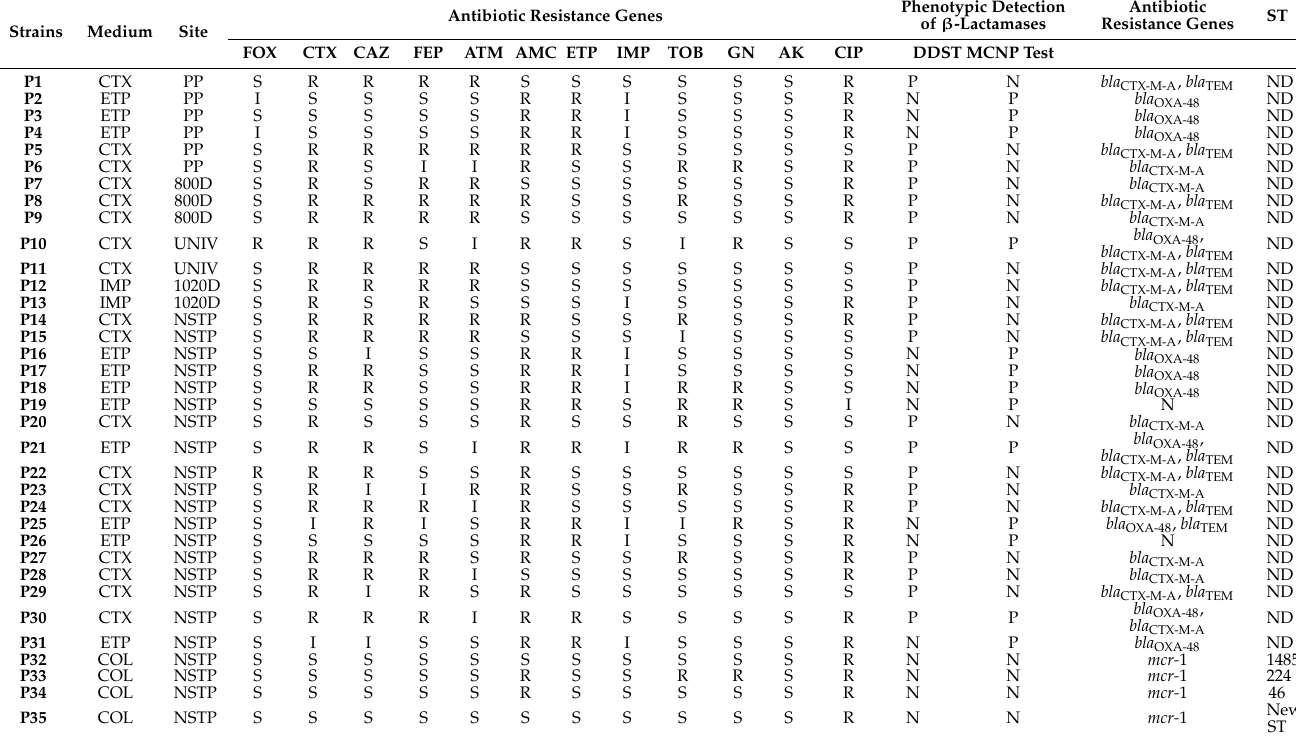
Table 2. Antibiotic susceptibility testing, resistance genes, and sequence types of the E. coli isolates obtained in this